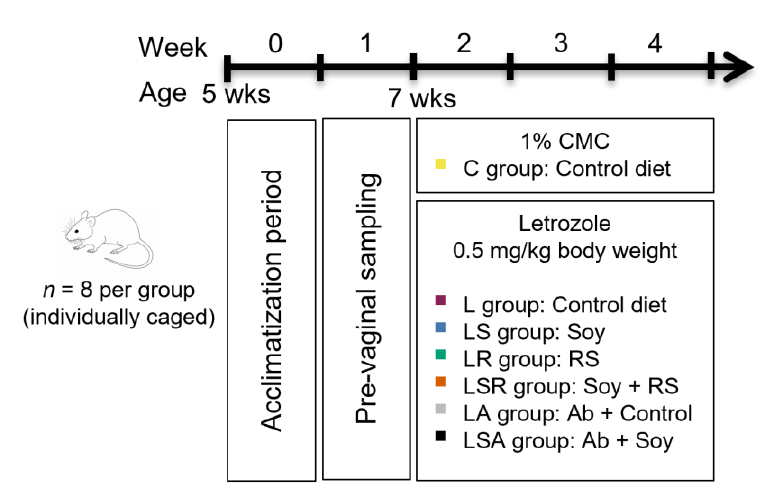
Figure 1. Schematic diagram of the animal experiment. Five-week-old female Sprague Dawley (SD) rats were used for the experiment. After acclimatization and the prevaginal sampling period, rats were divided into seven groups ( n = 8, 7 weeks old). All animals were housed in individual cages. PCOS symptoms were induced using oral gavage of 0.5 mg/kg letrozole for 21 days simultaneously with the diet treatments. The control group was treated with 1% CMC. Control and L groups were given the control diet. The LS group was given a 0.05% soy isoflavone-based diet. The LR group was given an 11% resistant starch (RS)-based diet. The LSR group was given a mixture of both. The PA group was given the control diet along with an antibiotic cocktail (Ab). The PSA group was given the antibiotic cocktail with the control diet. CMC = carboxymethyl cellulose .